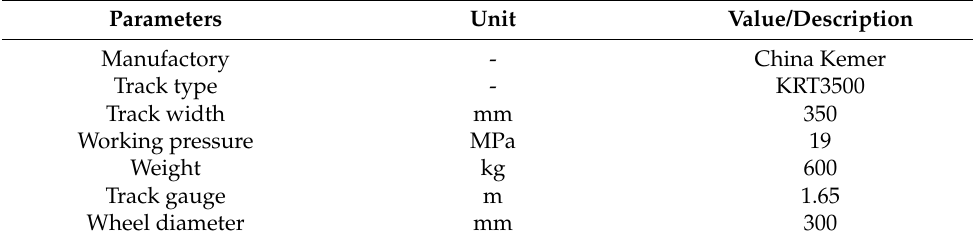
Table 3. Crawler chassis specification.